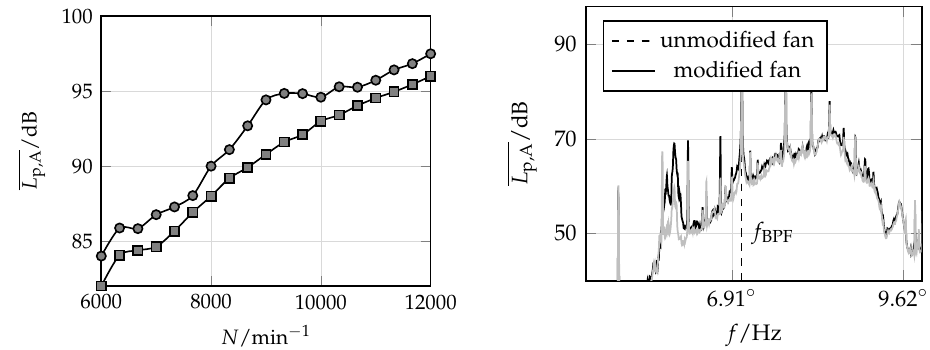
) and modified ( (cid:4) ) and •